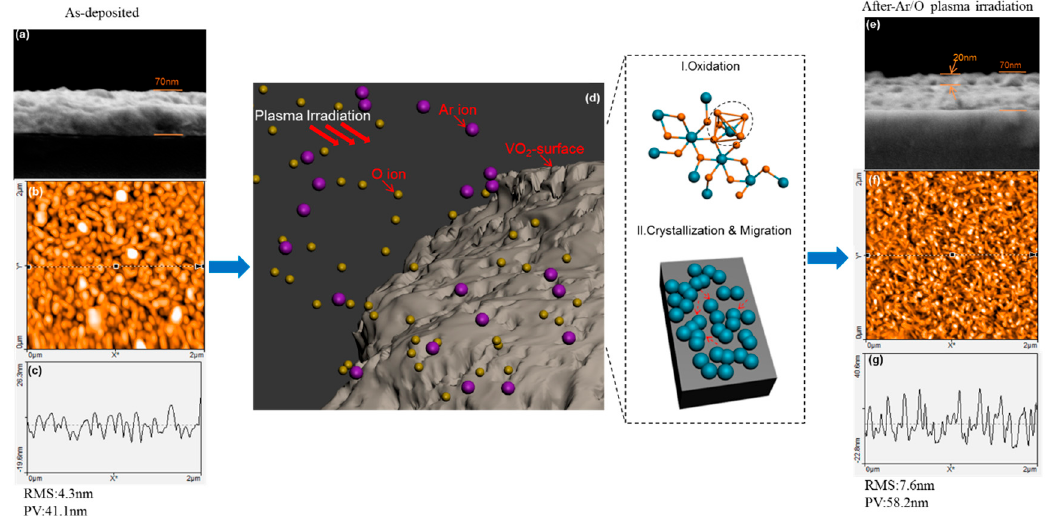
Figure 3. Schematic of Ar/O plasma irradiation and corresponding effect on the VO 2 film surface ( d ); Cross ‐ section SEM images of as ‐ deposited VO 2 films ( a ) and films irradiated with Ar/O plasma (500 W) ( e ); atomic force microscopy (AFM) images and line profiles of untreated VO 2 films ( b , c ) and films irradiated with Ar/O plasma (500 W) ( f , g ).